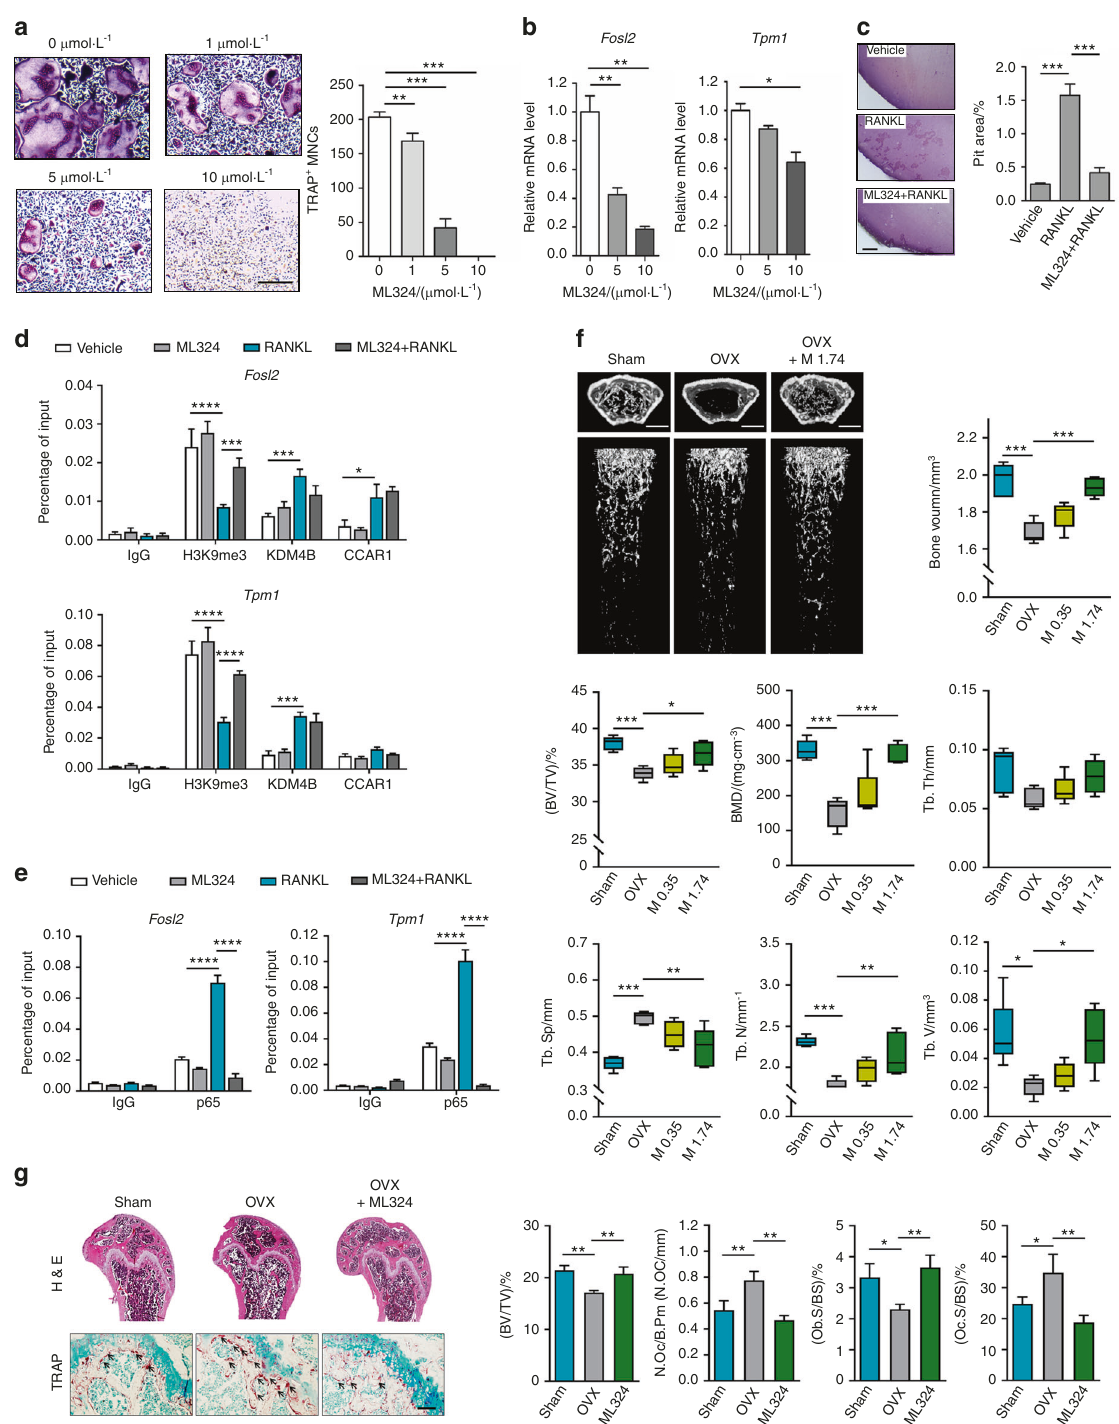
Fig. 7 Administration of KDM4B inhibitors ameliorates bone loss in the ovariectomized (OVX) mouse model. a TRAP staining of BMMs treated with ML324. Scale bar, 75 μ m. b mRNA expression levels of Fosl2 and Tpm1 in the cells evaluated in ( a ). c BMMs were treated with vehicle or 10 μ mol·L − 1 ML324 in the presence or absence of RANKL (100ng·mL − 1 ) for 10 days. The dentin slices were stained with Mayer ’ s hematoxylin, the resorption pit area was analyzed. Scale bar, 200 μ m. d , e ChIP assay of H3K9me3, KDM4B, CCAR1, and p65 occupancy at the Fosl2 promoter or Tpm1 promoter in BMMs treated with ML324 (10 μ mol·L − 1 ) and/or RANKL for 30 min. f Micro-CT analysis of the femurs of 4-month-old sham-operated, saline-treated (Sham), saline-treated OVX (OVX), and ML324-treated OVX (OVX + M 1.74) mice ( n = 5). Left panel, representative micro-CT image of a proximal femur (top, axial view; bottom, longitudinal view). Right panel, bone parameters. M 0.35, 0.35 mg·kg − 1 body weight; M 1.74, 1.74 mg·kg − 1 body weight. Scale bars, 1mm. g Histological analysis of femur sections from the mice evaluated in ( f ) ( n = 3). ML324, 1.74mg·kg − 1 body weight. The sections were stained for H&E and TRAP. The arrows indicate osteoclasts. Scale bars, 100 μ m. The data are presented as the mean ± SD values of three independent experiments [one-way ANOVA in ( a – c ) and two-way ANOVA in ( d , e )]. The data in ( f , g ) are presented as the mean ±SEM values (one-way ANOVA). * P < 0.05; ** P <0.01; *** P <0.001. See also Supplementary Figs. 7 and